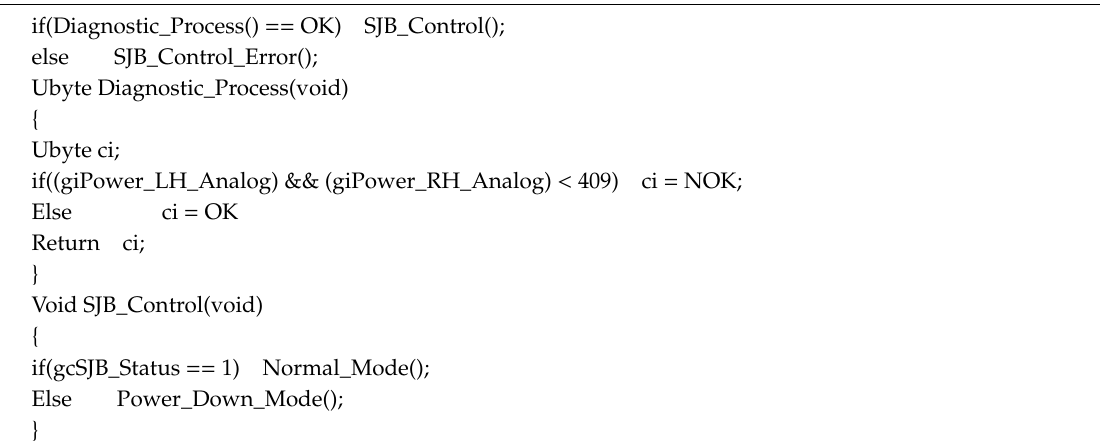
Algorithm A1. SJB Status Check(Diagnosis(), Mode